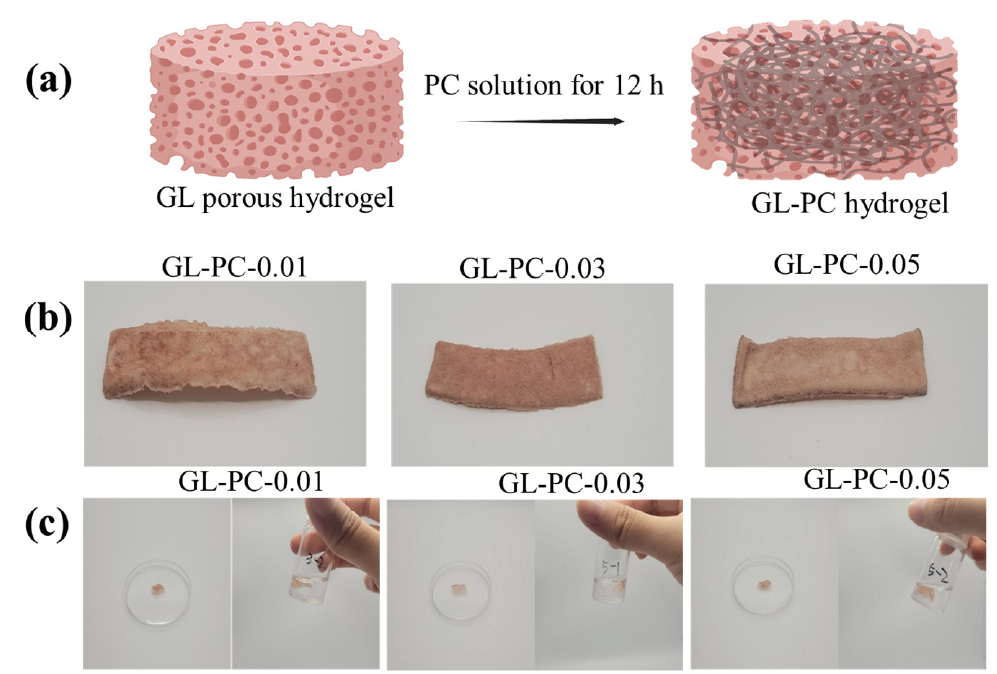
Figure 1. ( a ) Schematic representation of preparation of GL-PC porous hydrogels for cultivated meat production, ( b ) digital photograph images of GL-PC hydrogels after freeze-drying, and ( c ) digital photograph images of the stability of GL-PC hydrogels in PBS (pH 7.4) at 37 °C.